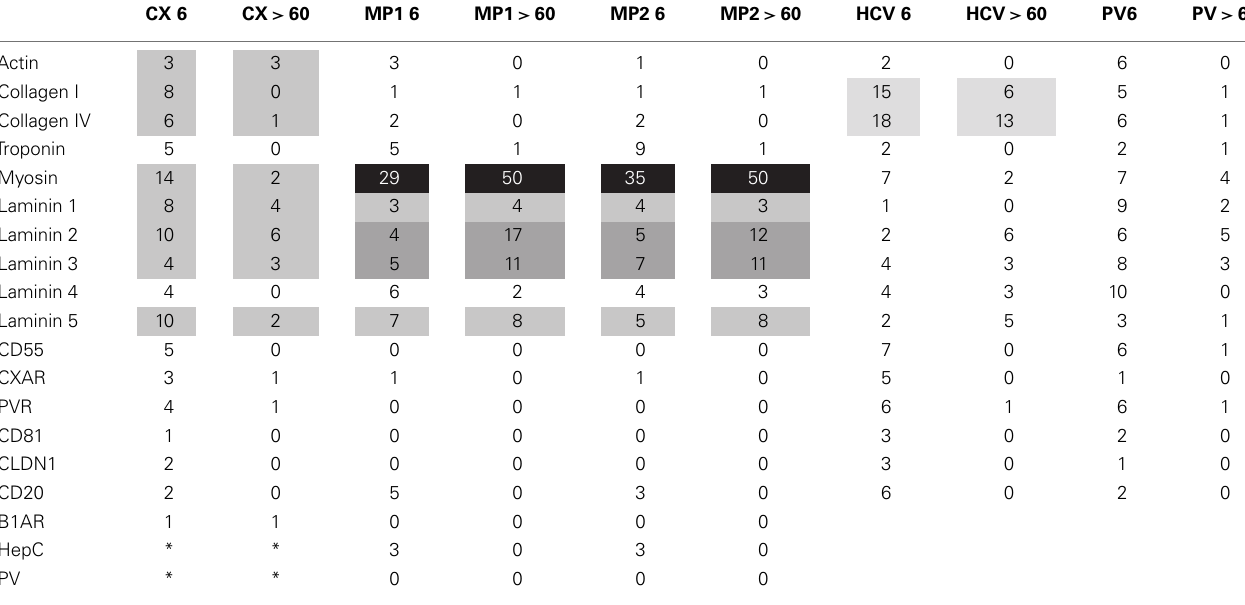
Table 1 | Summary of results of BLAST 2.0 similarity searches comparing the human proteins (left) with the pathogens (top)